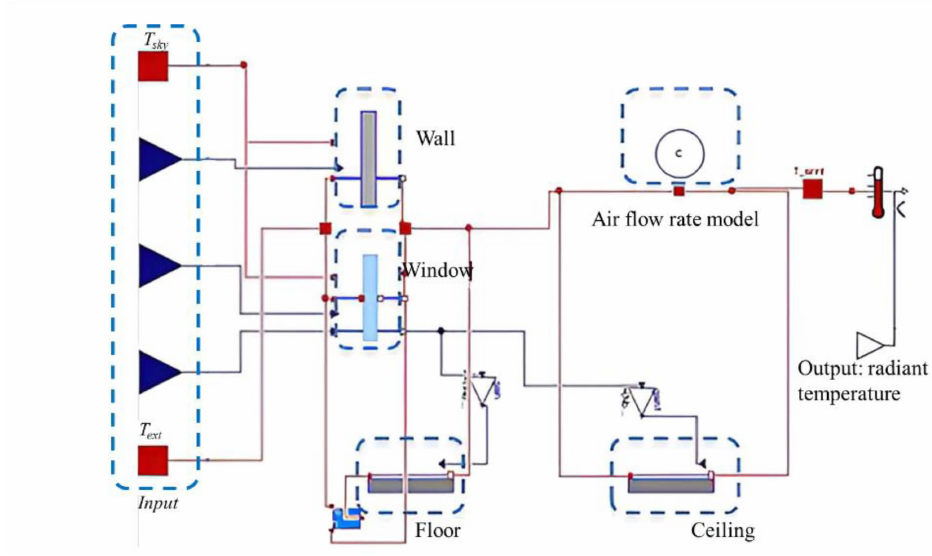
Figure 6. Numerical simplified